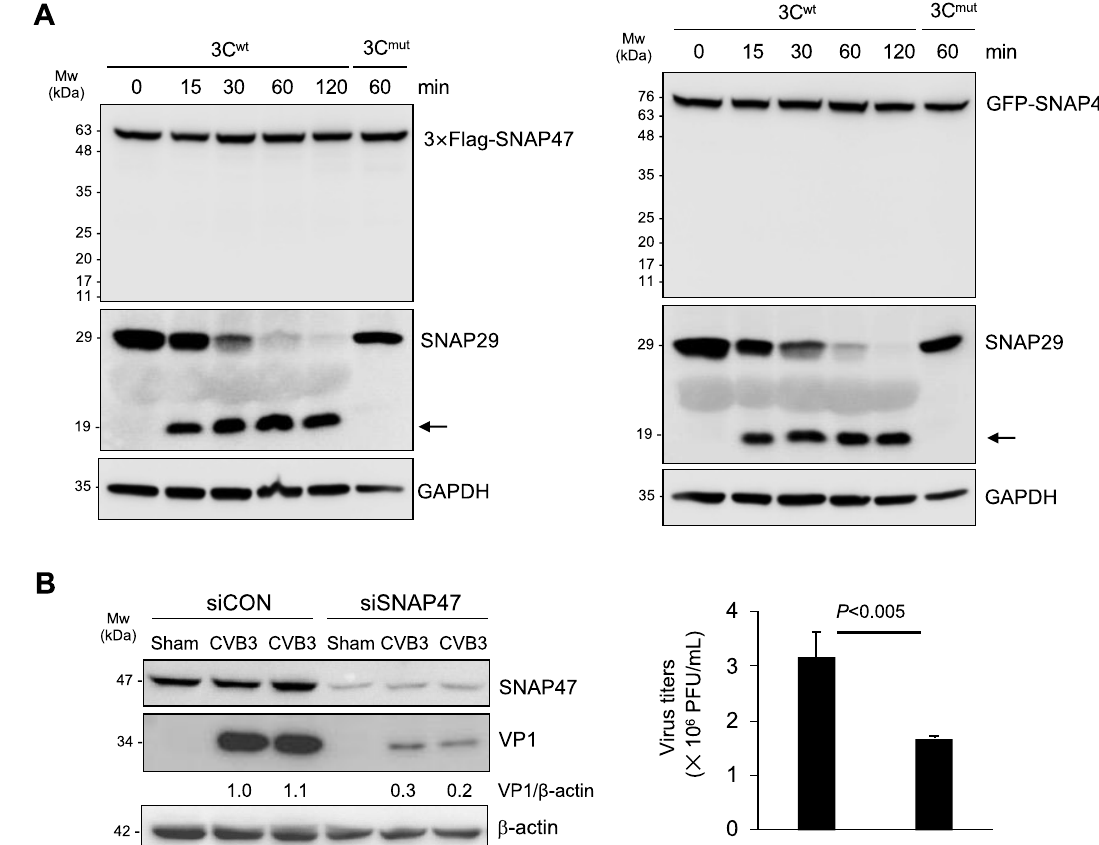
Figure 2. Downregulation of SNAP47 is independent of viral proteinase 3C and results in decreased viral propagation. ( A ) Lysates extracted from HeLa cells overexpressing 3 × Flag-SNAP47 (left panels) or GFP-SNAP47 (right panels) were incubated with purified 3C proteinase for different timepoints for in vitro cleavage assay. 3 × Flag or GFP was blotted to assess the protein levels of exogenous SNAP47. Mutant 3C (3C mut ) was used as a negative control while SNAP29 was blotted as a positive substrate to confirm proteinase activity. Arrows denote the expected cleavage fragment of SNAP29. ( B ) HeLa cells transfected with control or SNAP47-specific siRNAs were infected with CVB3 at an MOI of 0.1 for 24 h. Western blot analysis was conducted to examine the protein level of VP1 and β-actin (left panel). Densitometry was performed and the ratio of VP1/β-actin is presented underneath the blot. TCID50 assay was conducted to determine viral titer in control and SNAP47-knockdown cells (mean SEM, n = 3, right).